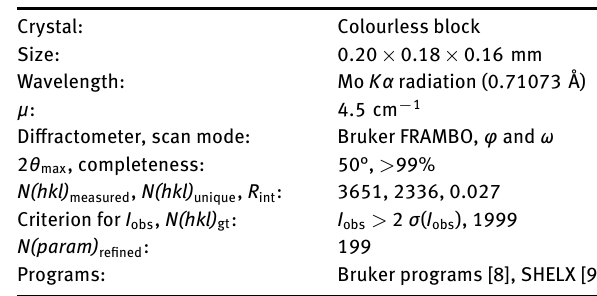
Table 1: Data collection and handling.